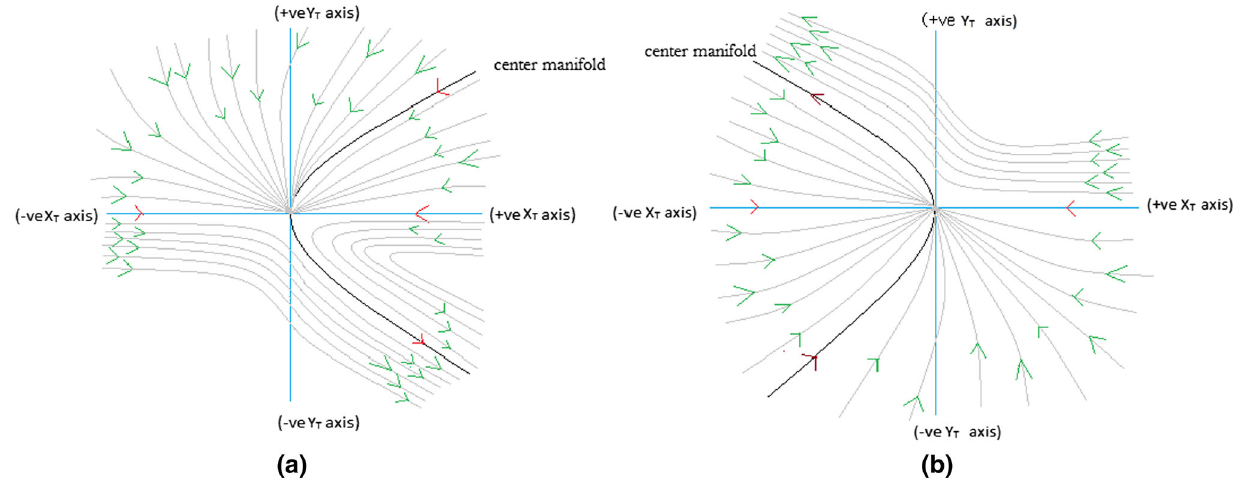
Fig. 2 Vector field near the origin for the critical point C 2 in ( X T Y T )-plane. L.H.S. is for μ < 0 and R.H.S. is for μ >